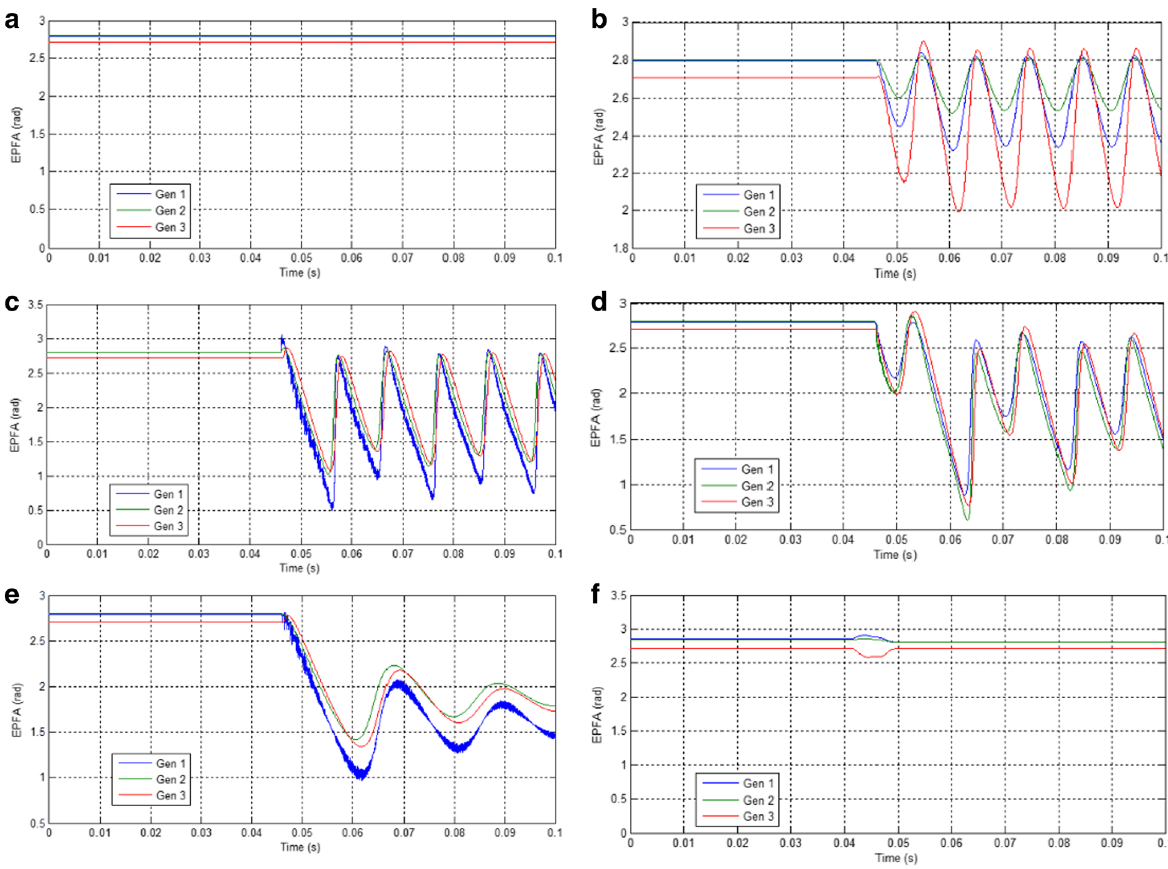
Fig. 3 a EPFA variation during no-fault condition in WSCC-9bus system. b . EPFA variation during LG-Fault condition in WSCC-9bus system with FR = 0 Ω and FIA = 0°. c . EPFA variation during LL-Fault condition in WSCC-9bus system with FR = 0 Ω and FIA = 0°. 3 d . EPFA variation during LLG-Fault condition in WSCC-9bus system with FR = 0 Ω and FIA = 0°. e . EPFA variation during LLL-Fault condition in WSCC-9bus system with FR = 0 Ω and FIA = 0°. f . EPFA variation during wide area load change in WSCC-9bus